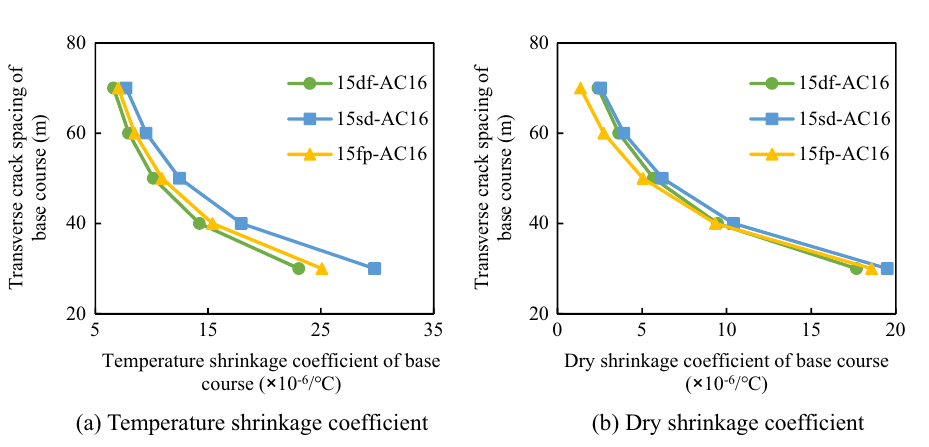
Figure 15. Relationship between the transverse crack spacing and shrinkage coefficients of the semi-rigid